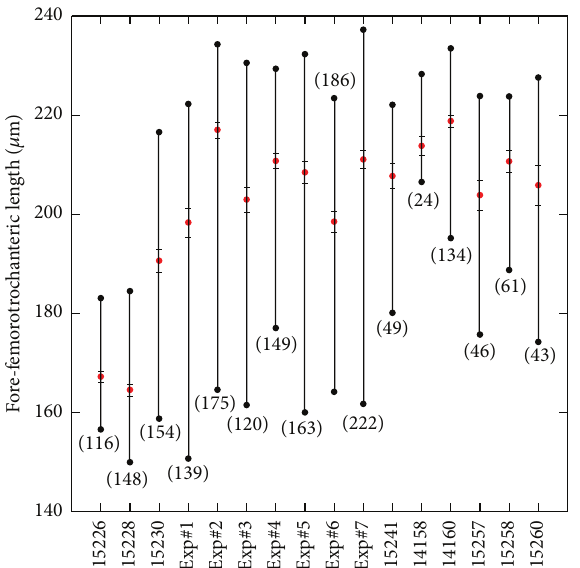
Figure 7: Lengths of fore-femorotrochanters of first-instar nymphs to be alates for 16 woolly colonies. Mean ± 2SE are shown by a red closed circle and two short horizontal bars on the vertical line which indicatestherange. Numberinparenthesisindicatesthesamplesize. The colony codes shown below the horizontal axis are the same as in Table